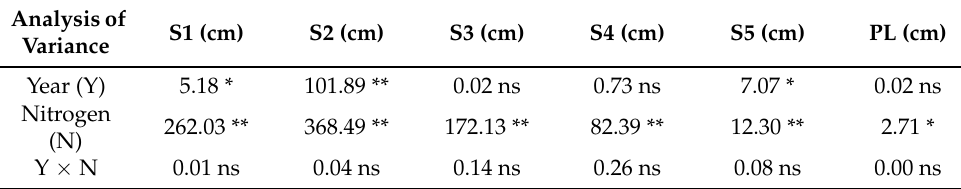
Figure 4. Internode length under different N application rates in 2019 and 2020. N0, N1, N2, N3, N4 and N5 refer to the N application rate being 0, 70, 140, 210, 280 and 350 kg ha − 1 , respectively. S1, S2, S3, S4, and S5 denote the first internode to the fifth internode base from the stem base, respectively. Panicle length (PL). The same letter means they do not have significantly different at the 0.05, the different letter means they have significantly different at the 0.05. Table 2. Analysis of variance of internode length and panicle length.